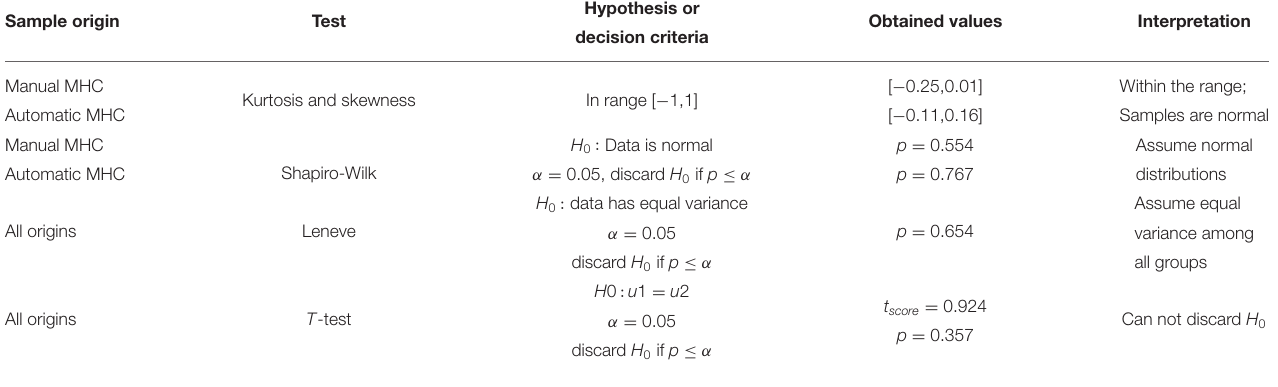
TABLE 5 | Comparing the MHC measurement perform by human operators and the automatic estimator for a sample size n = 49.